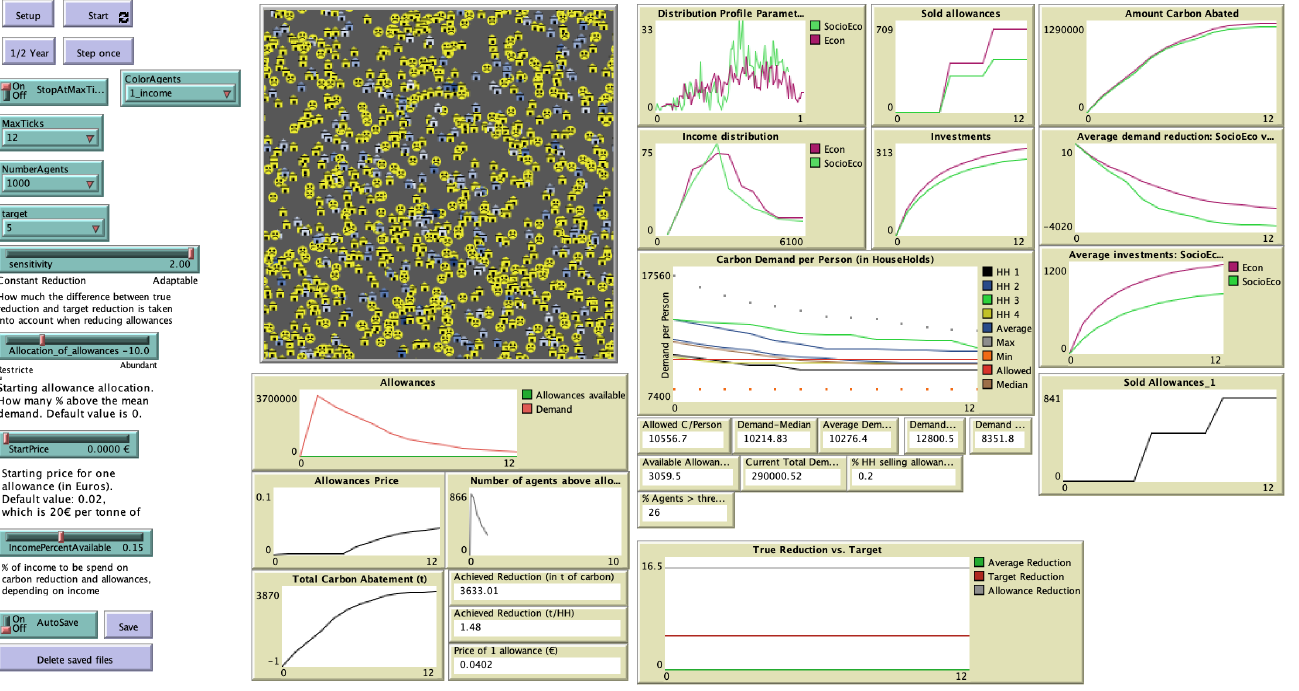
Figure 1. The interface of the PCT model at the end of a simulation run, as described in the text. Users can control parameters using the turquoise controls on the left and view the dynamics and values of variables of interest in the monitors and plots in the center and right. See Sections 3 and 4 for